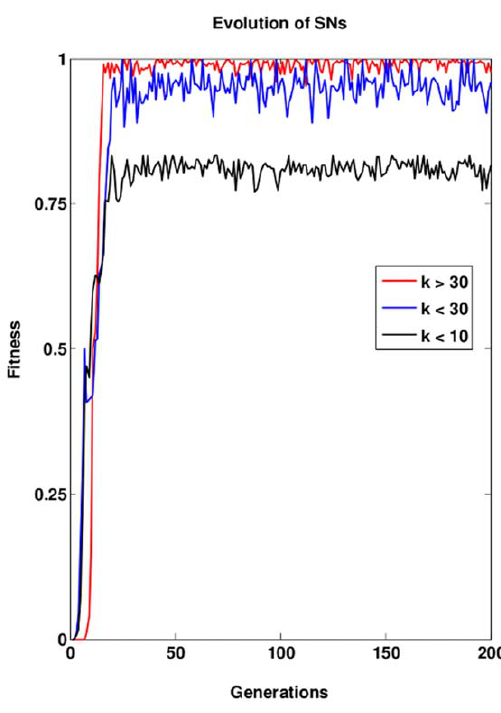
Figure 3. Evolution of SNs by mutating kinetic parameters. The represents the fitness ( F norm) during the evolution of SNs for three different regimes 1 of maximal interaction strengths: weak ( k v 10 ), moderate ( k v 30 ), and and A 2 . strong ( k w 30 ) interactions (Number of generations: 200, Number of 1 1 th of the initial concentration level of SNs: 200, Threshold level: 10 protein).